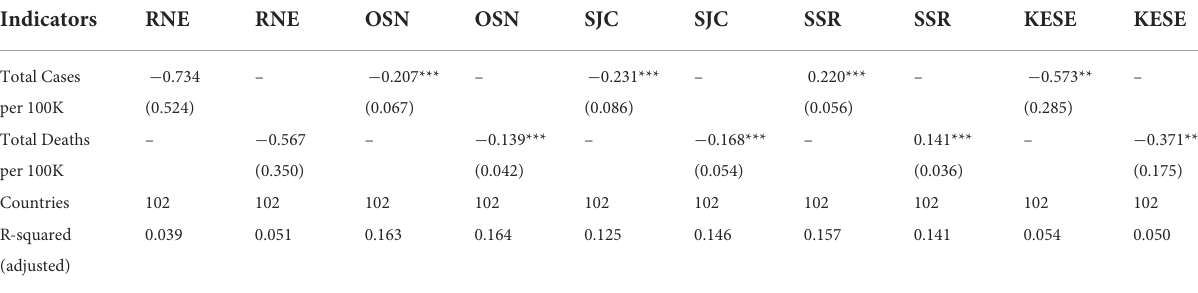
TABLE 6 Fixed effects estimations for the effects of the COVID-19 pandemic on early-stage entrepreneurship indicators.